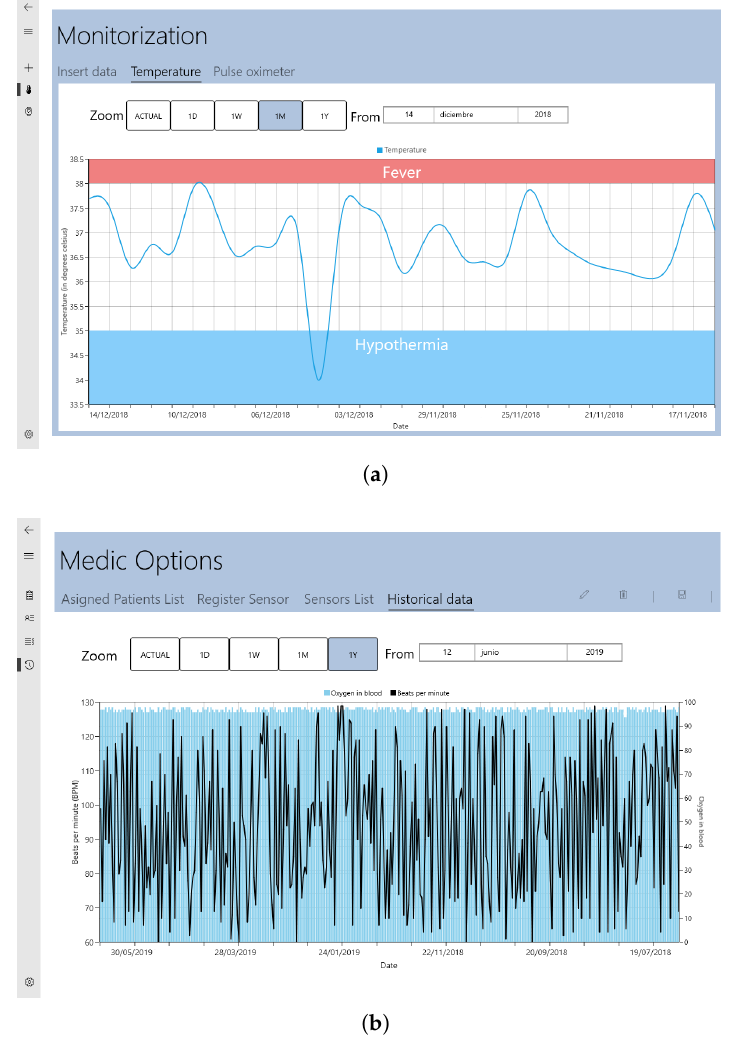
Figure 5. Visualisation of historical data by role ( a ) patient, ( b )